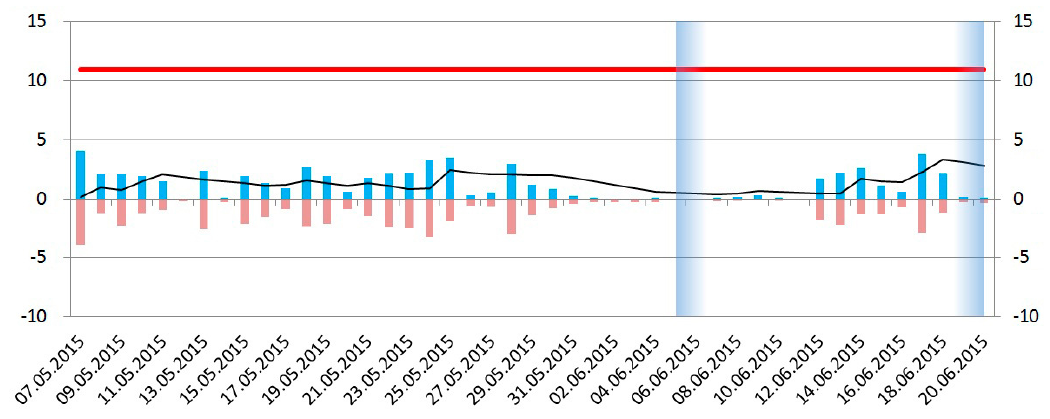
Figure 2. Water balance of the Louisiana flood: light blue bars represent precipitation values, pink bars—combined evaporation and permeation values, thin black line—accumulated water mass, thick red line—fixed maximum of observed water mass.